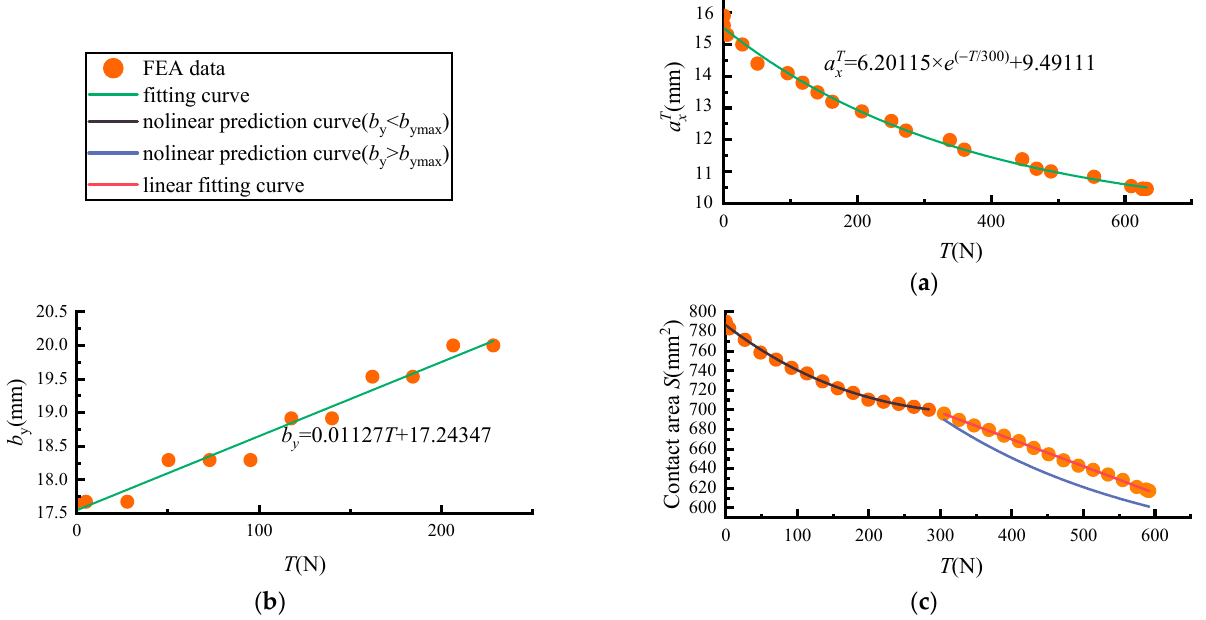
a and T ; ( b ) relation- x